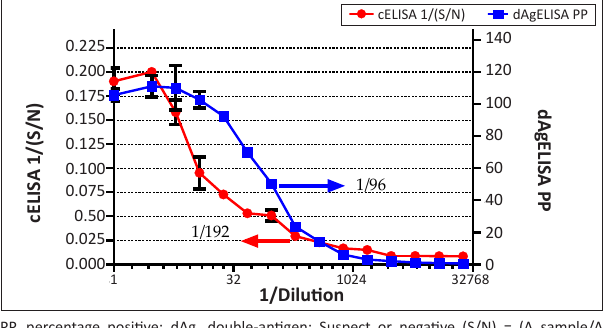
PP, percentage positive; dAg, double-antigen; Suspect or negative (S/N) = (A sample/A negative control) × 100. Note: The limit of detection for the double-antigen ELISA is one dilution lower than for the cELISA, namely 1:96 compared to 1:192. FIGURE 3: Analytical sensitivity of the double-antigen ELISA compared to the cELISA for the detection of the positive control and dilutions thereof.